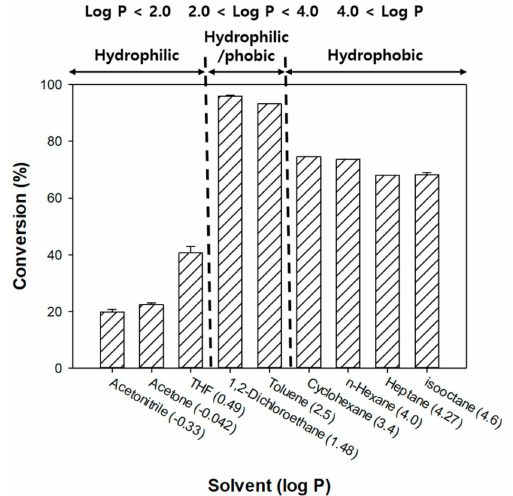
Figure 6. E ff ect of solvent log P on the Novozym 435-catalyzed synthesis of phenethyl formate. The conversion yield (%) was calculated by GC